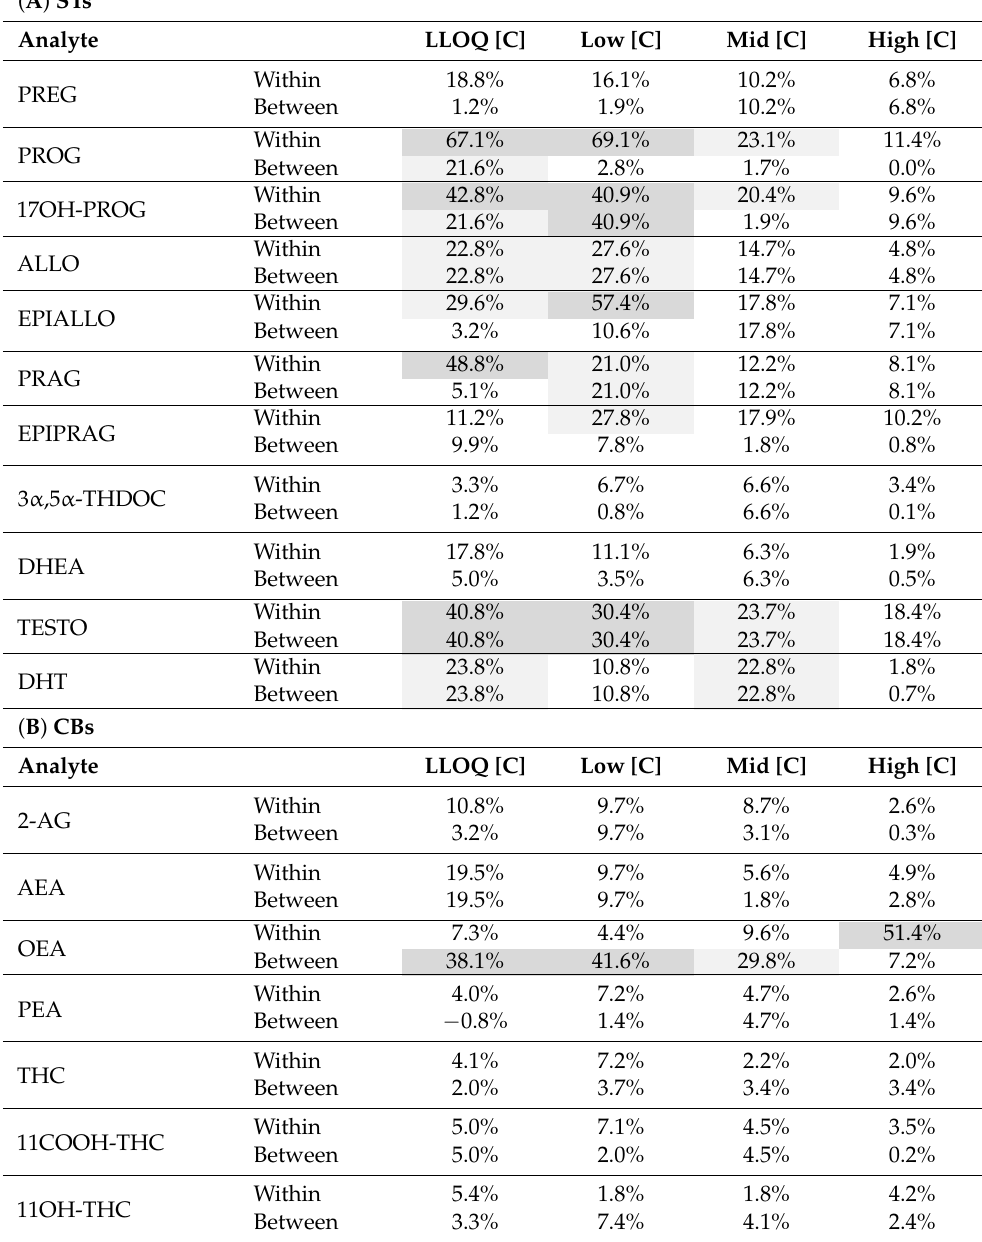
Table 8. Within- and between-run precision for steroids (STs) ( A ) and cannabinoids (CBs) ( B ) at low, mid, and high concentration levels (corresponding to CC2, CC4, and CC8 concentration levels, respectively, of the calibration